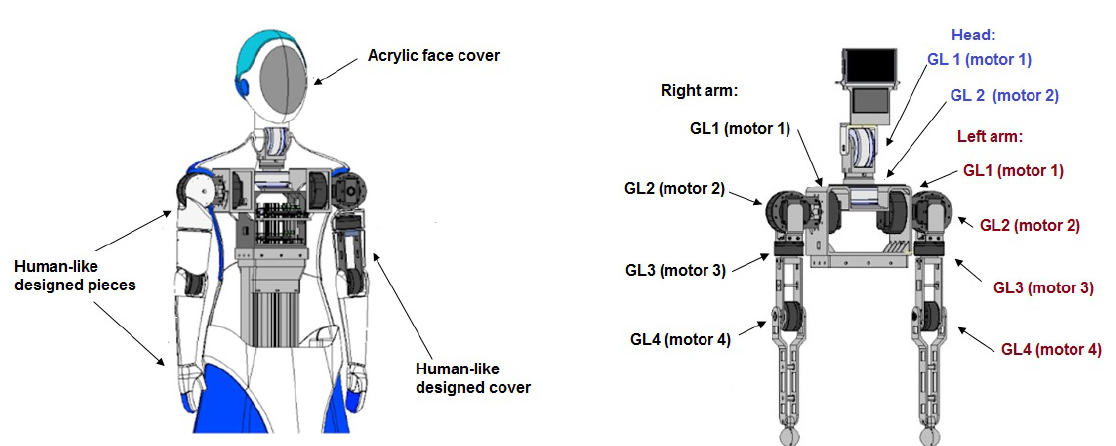
Figure 1. 3D model of three conceptual designs of the robotic arms and head.